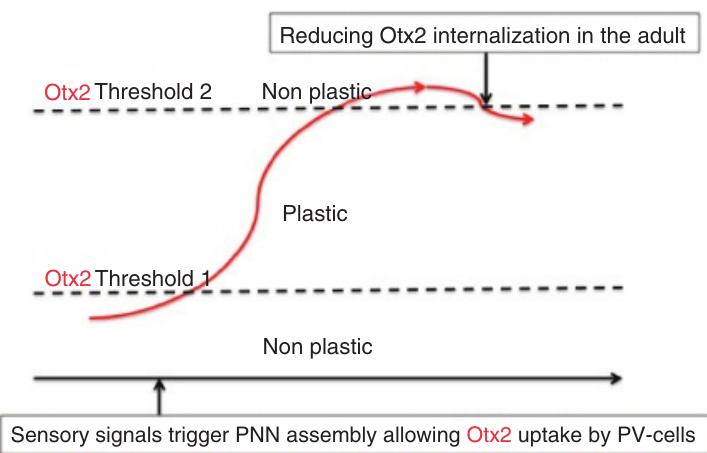
Figure 2. Critical period and the role of Otx2. Sensory signals, for example eye opening at P14 in the mouse, triggers Perineuronal net (PNN) assembly at the surface of Parvalbumin neurons in layers III/IV of the visual cortex. PNN complex sugars specifically recognize Otx2 en route from extra-cortical sources and enhance its internalization by Parvalbumin neurons, thus triggering the maturation of this class of interneurons. Otx2 reaches a first intracellular concentration threshold that opens plasticity and accumulates until a second threshold closes plasticity. The maintenance of an adult non-plastic state requires the continuous import of Otx2 from extra-cortical sources and blocking the latter import reopens a window of plasticity in the